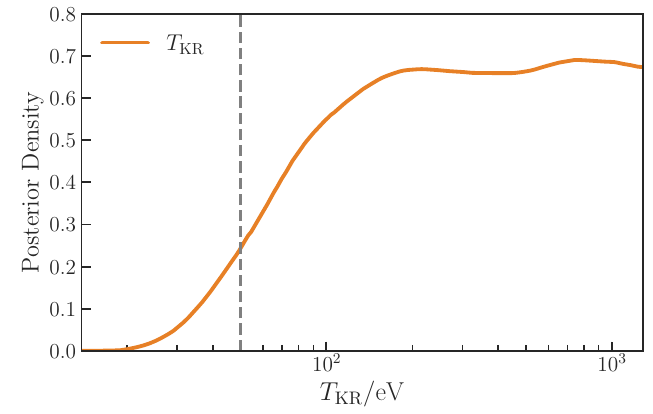
Figure 3 . Posterior distribution for T KR for a late era of kination. We use Planck temperature and polarization data (highTTTEEE+lowEE+lowTT) to constrain T KR > 50 eV at 95% (vertical dashed line). See figure 16 for the complete 2-dimensional posterior distributions for ΛCDM + T KR